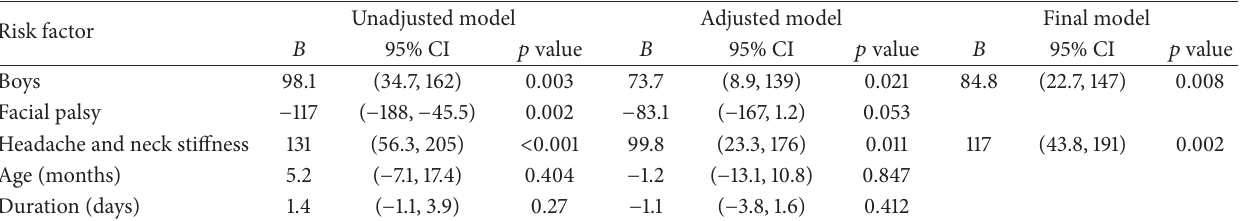
Table 3: Linear regression model with cerebrospinal fluid white blood count as dependent variable in 142 children hospitalized with Lyme neuroborreliosis at Stavanger University Hospital during